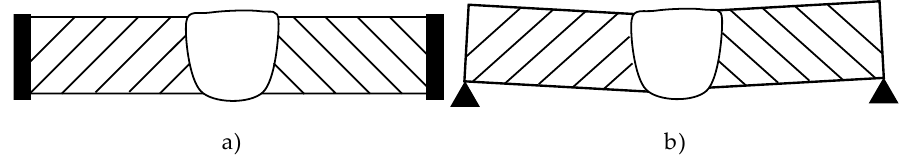
Figure 7. Test part placing examples: properly clamped ( a ) and simply supported ( b ).